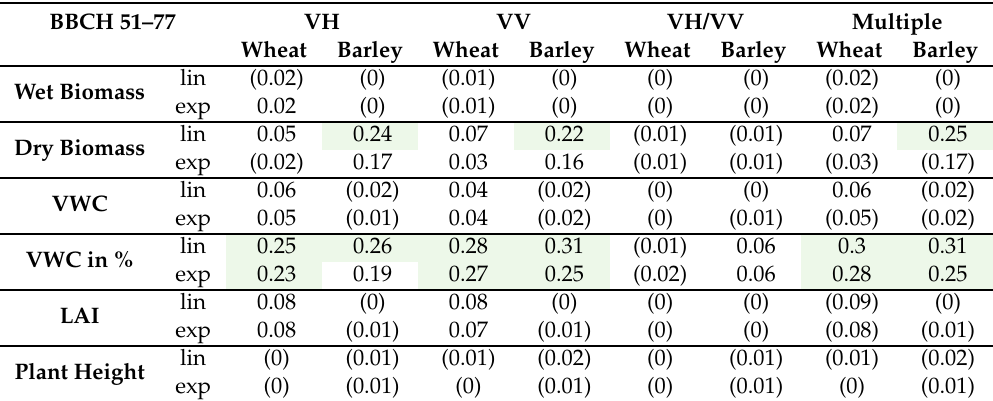
Table 5. R 2 values of the regression between crop and backscatter parameters per crop type for all fields in BBCH stages 51–77. Values in parentheses are not significant ( p >